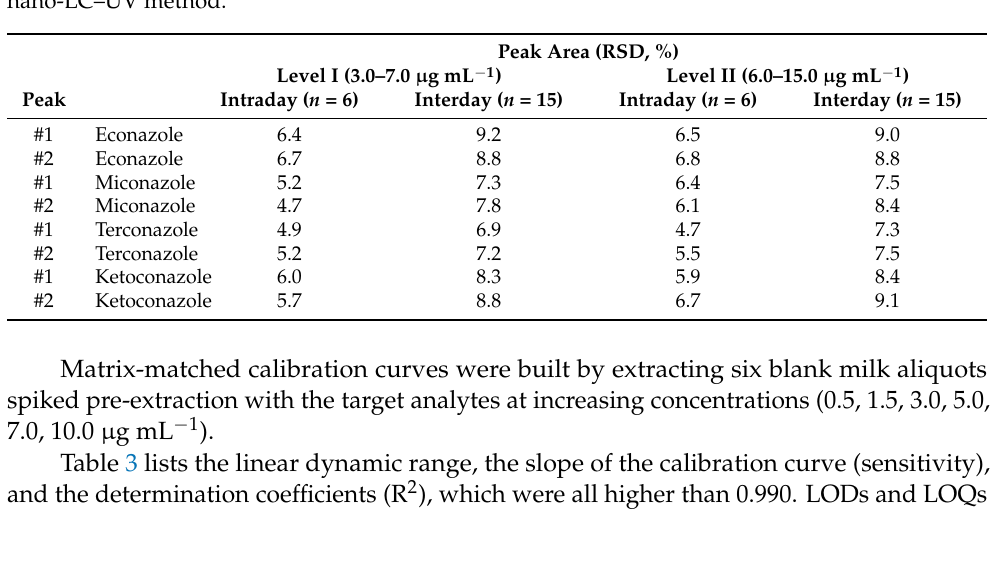
Table 2. Peak area repeatability and reproducibility of spiked milk samples obtained with DLLME– nano-LC–UV